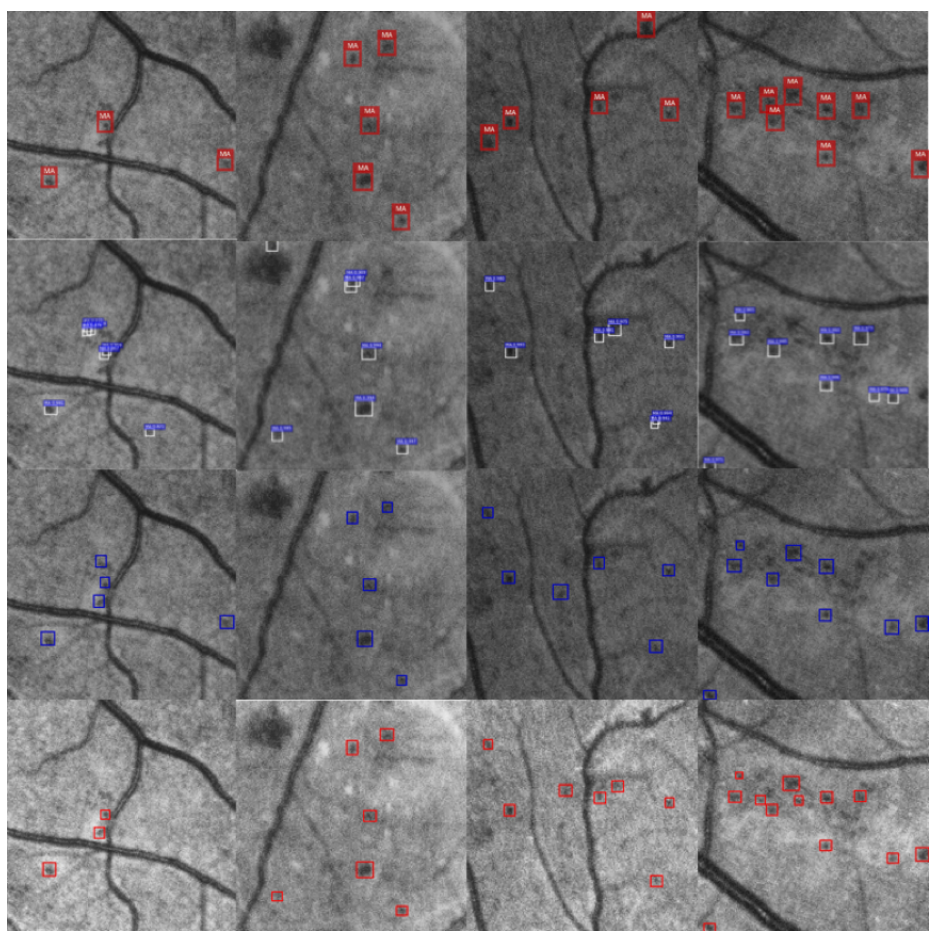
Figure 9. Detection results with an IoU threshold of 0.5. The first row corresponds to SSD, the second row shows the detection results of Faster R-CNN, the third row shows the detection results of AttractioNet, and the last row shows the results of our method, which performs the best on this